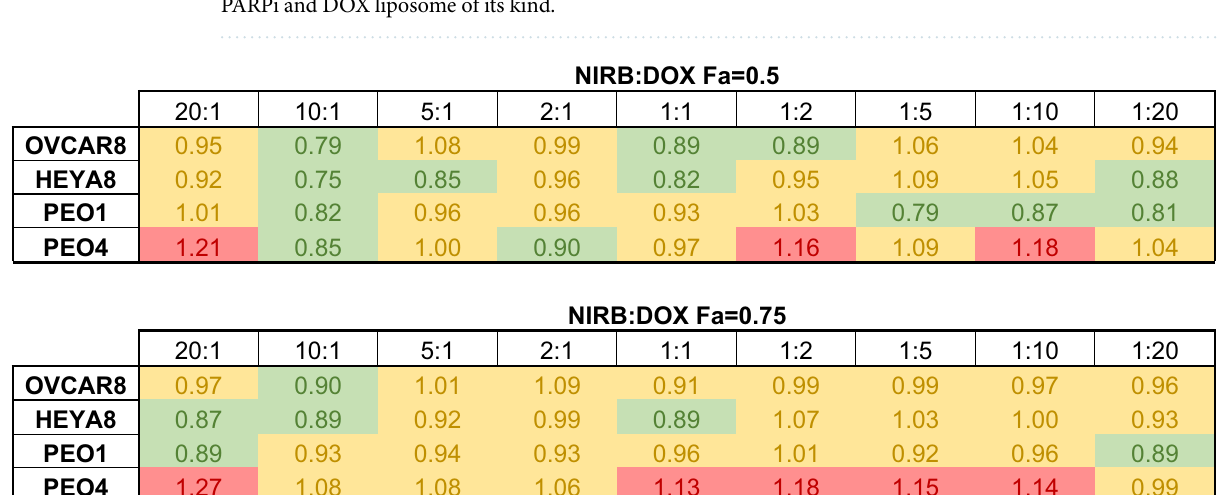
Figure 1. Graphical schematic of the presented synergistic, actively targeted, dual encapsulated NIRB and DOX liposome. The formulated nanoparticle is designed and optimized to deliver a pre-screened, synergistic combination of NIRB and DOX to HGSOC cancer cells. This is, to our knowledge, the first reported dual loaded PARPi and DOX liposome of its kind.